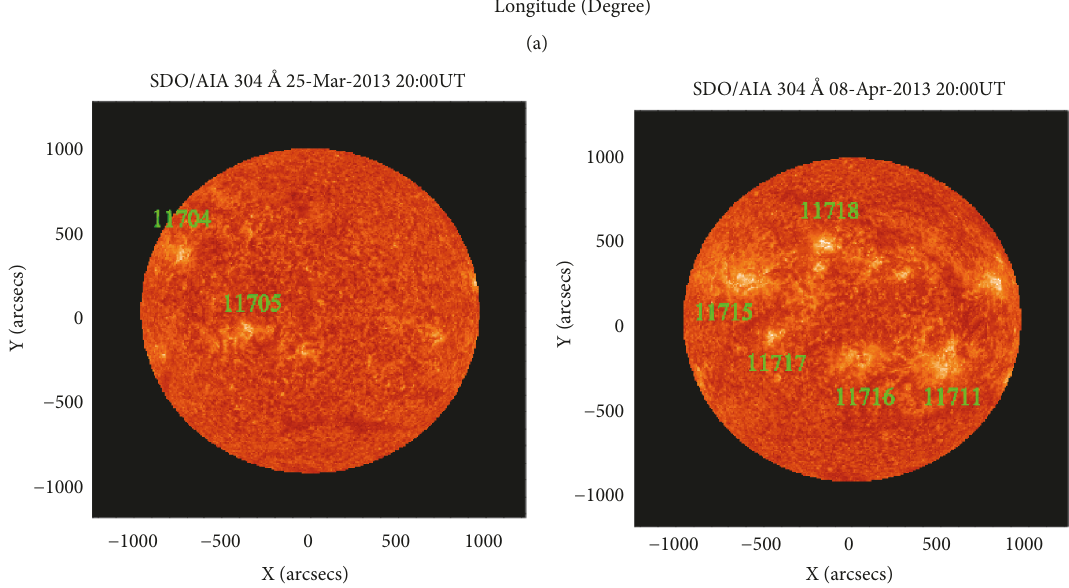
Figure 11: The 304 ˚A full-disk EUV image on 25 March 2013 (a) and Earth-side EUV images on 25 March 2013 (b) and 8 April 2013 (c).